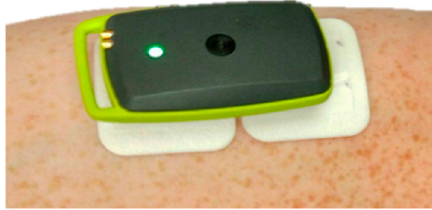
Figure 4. Electromyographic (EMG) Holter fixed to the body using Ag/AgCl electrodes.